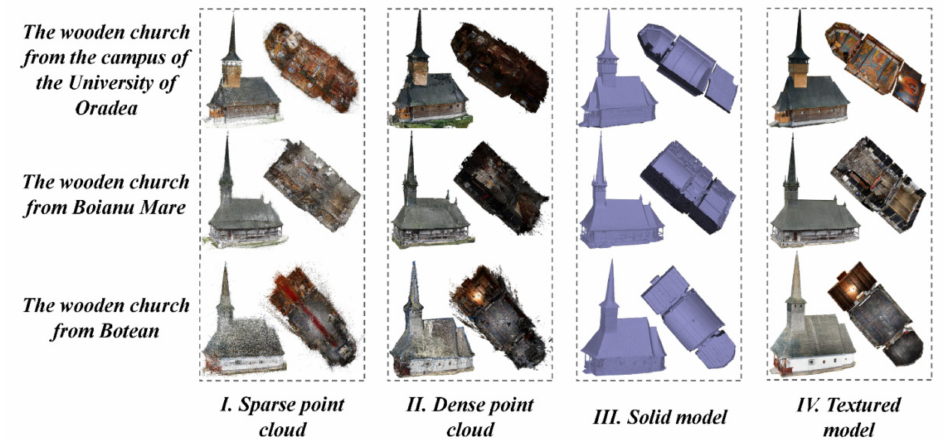
Figure 6. The results obtained during each stage of making the three-dimensional models concerned (with the representation showing the models resulting from the cleaning and optimisation actions that were undertaken specifically to each stage of the